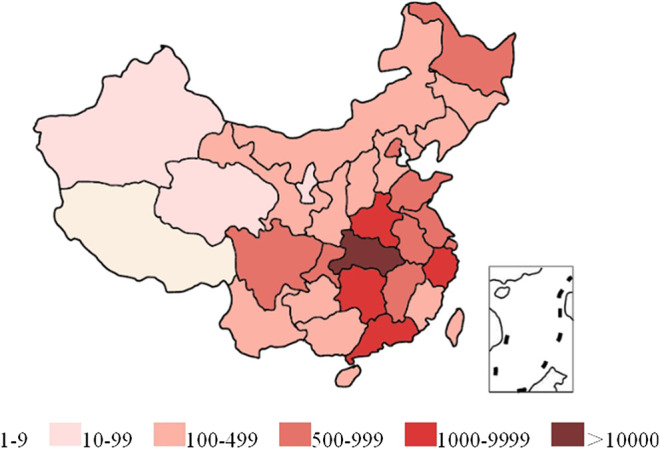
Six levels of confirmed cases in China.